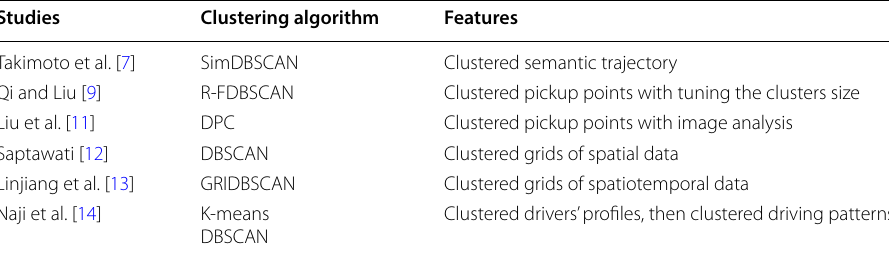
Table 1 Existing taxi clustering techniques Studies Clustering